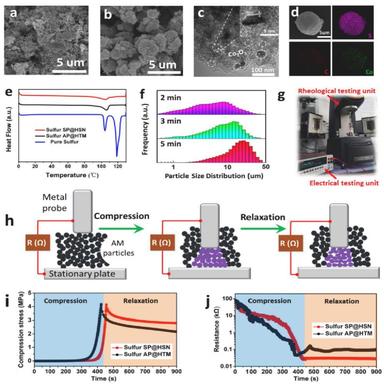
Structrues and properties of the S-rich SP@HSN as compared with conventional S/C composites. (a) SEM image of the control sample, sulfur AP@HTM; (b) SEM image of the S-rich SP@HSN. (c) TEM image of the S-rich SP@HSN. (d) S, C and Co elements mapping by Energy-dispersive X-ray for a single S-rich SP@HSN particle. (e) The first heating curves by DSC for pure sulfur, sulfur AP@HTM and S-rich SP@HSN. (f) Size regulation of the SP@HSN by compositing time: 2 min (top), 3 min (middle), 5 min (bottom). (g) The digi